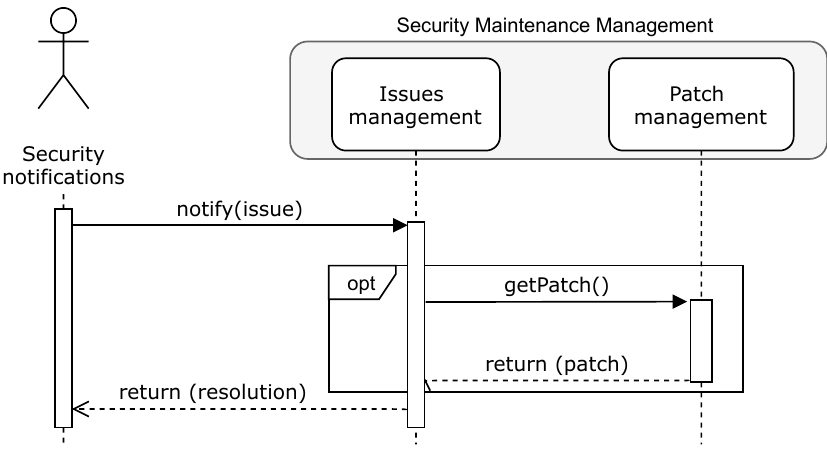
Figure 7. Security-related issues and patches management